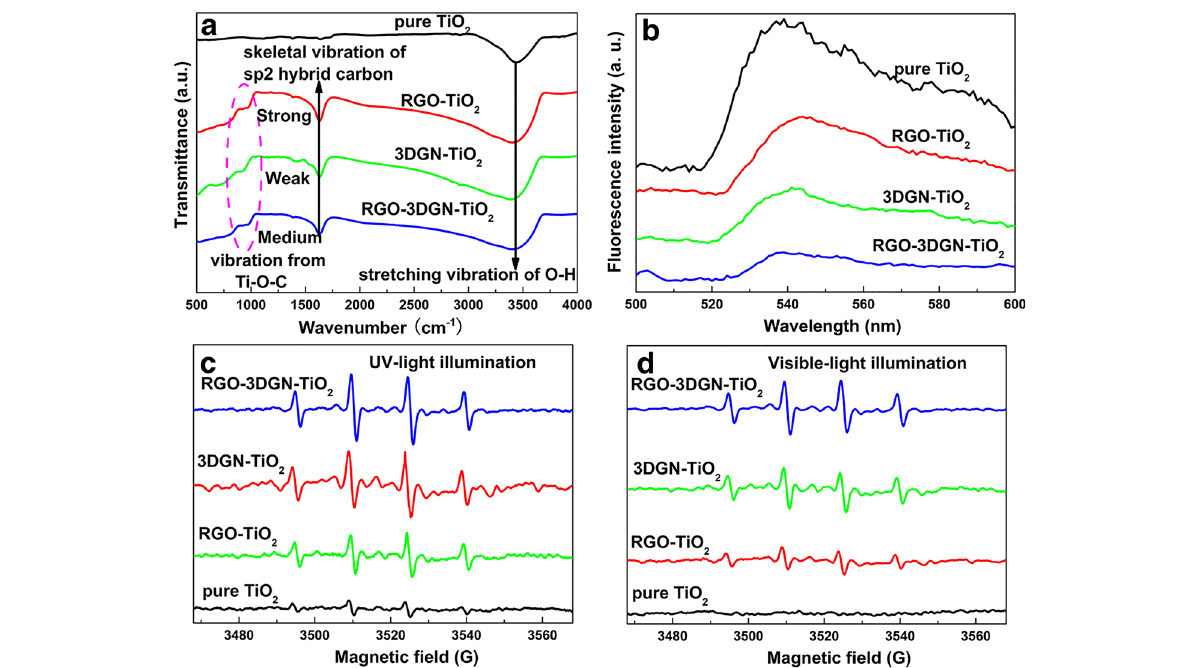
Fig. 3 Characterizations of various composite photocatalysts. a IR curves and b PL patterns of various photocatalyst, EPR spectra of radical adduct trapped by 5,5-dimethyl-1-pyrroline- N -oxide under c UV-light and d visible-light